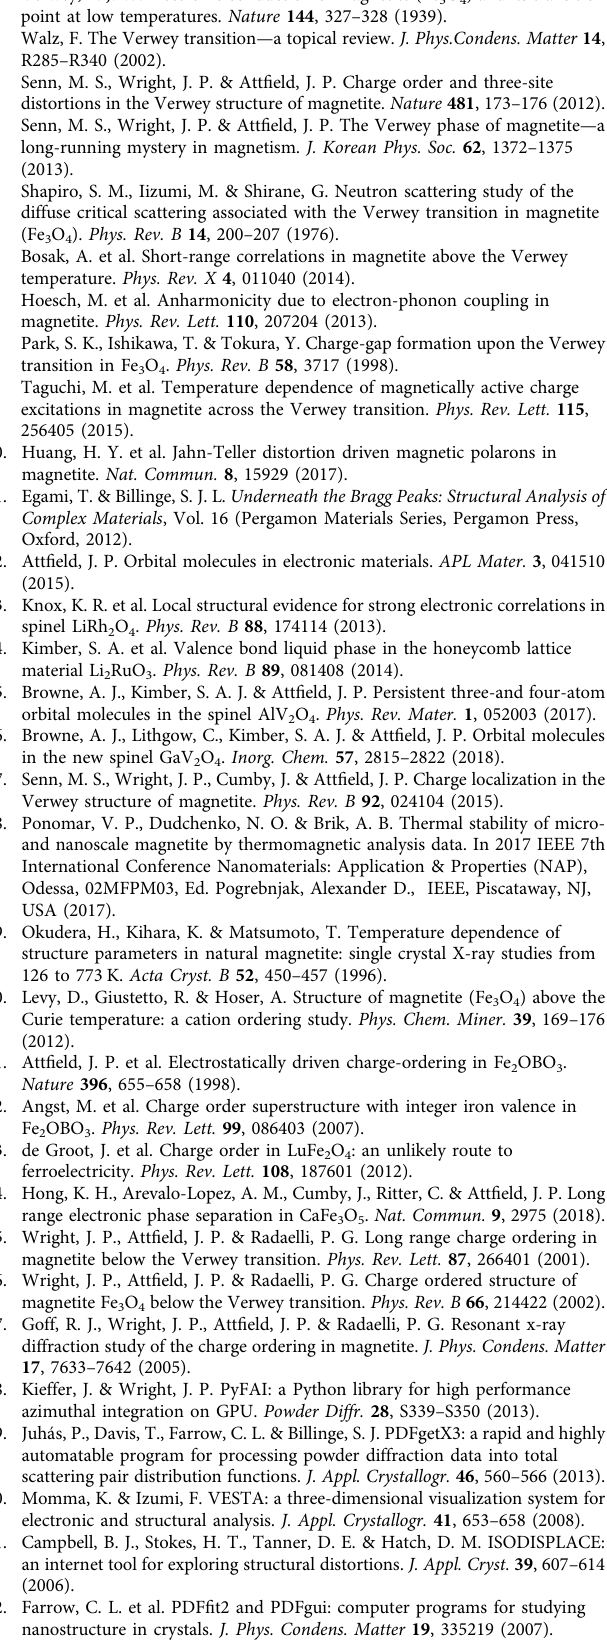
Supplementary Table 1. This model has f V = 0. The previously reported 90K monoclinic Cc structure 3 was transformed to the same cell metric (from a = 11.88881(3) Å, b = 11.84940(3) Å, c = 16.77515(1) Å, β = 90.2363(2)° to a = b = 11.86182(3) Å, c = 16.77515(1) Å, β = 90°). Atomic positions were shifted